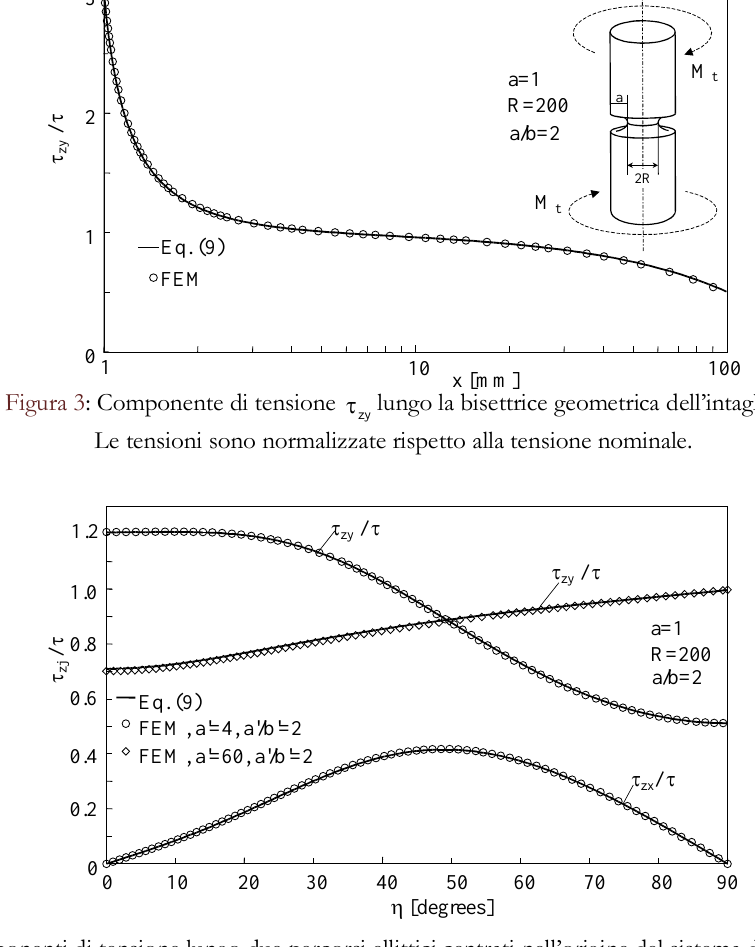
Figura 4: Componenti di tensione lungo due percorsi ellittici centrati nell’origine del sistema di riferimento (x,y); a’=4 mm e a’=60 mm, mentre a’/b’=2. Le tensioni sono normalizzate rispetto alla tensione